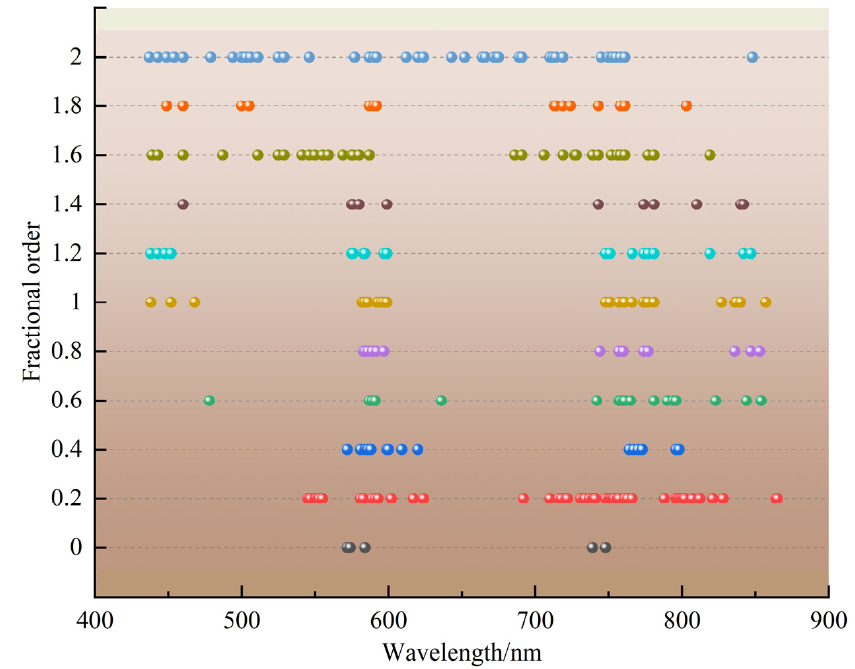
Figure 2. Distribution of hyperspectral sensitive bands with the VCPA-GA hybrid strategy (0–2 order), Dots of the same color respectively represent the characteristic variables screened out under different fractional order processing.